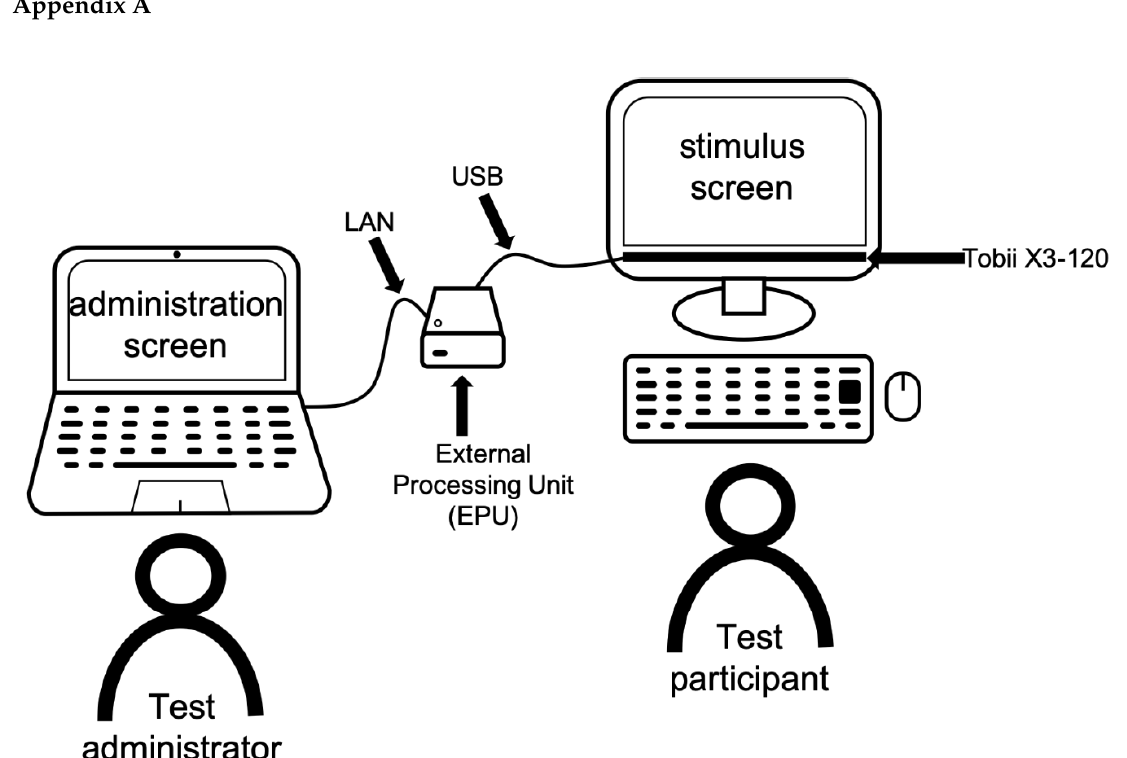
Figure A1. Experimental Setting .